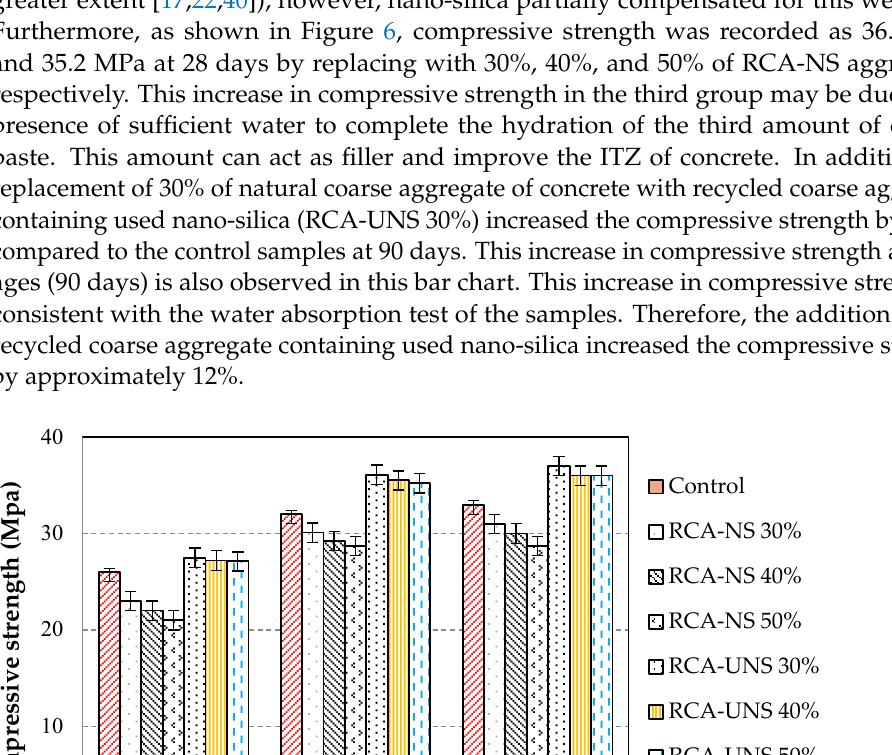
Figure 5. Water absorption of concrete samples at 28 days.